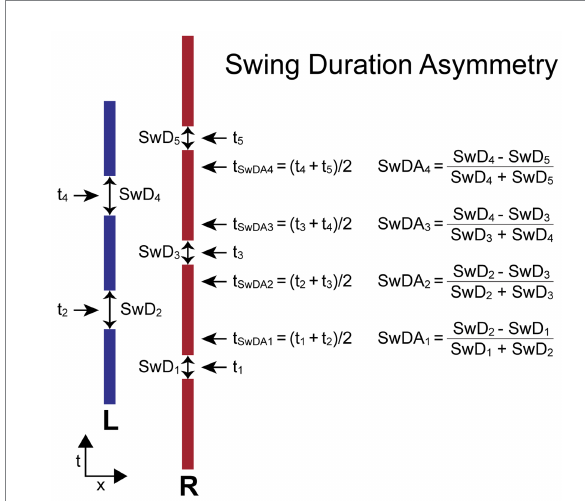
FIGURE 5 Swing Duration Asymmetry ( SwDA ) parameters and formula. Times t i are the times at the midpoint in time of the swing phase of gait when a foot is not in contact with the surface defined as the swing durations ( SwD i ). The difference between the values of SwD on adjacent steps divided by their sum determines the value of SwDA . The time point ( t SwDAi ) associated with each SwDA measure is the average of the midpoints in time of the right and left swing phases used for the SwDA calculation and occurs approximately at the midpoint of the double-leg support phase of gait. The calculations are shown for the condition where the first step is with the right (R) foot and differs from the calculation when the first step is with the left (L) foot so that a positive StDA measure is always indicative of a pattern of stepping where the R foot SwD is shorter than the L foot SwD